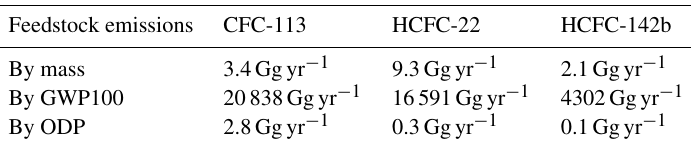
Figure 4. Emissions by source – Estimates of emissions by various equipment types, summarized in Table 1, are shown here along with estimated emissions from feedstock usage. Lines indicate the median estimate, with the shaded region indicating the 90% confidence interval. Halons are not included in this figure as 100% of halon emissions come from the same application and are thus identical to Fig. 2 halon totals. Table 3. Estimated feedstock emissions averaged from 2010–2019 from the Bayesian analysis. Emissions are weighted by mass, global warming potential (GWP100) relative to CO 2 over a 100-year time horizon for a CO 2 concentration of 391ppm, and by ozone depletion potential (ODP) relative to CFC-11 (WMO,